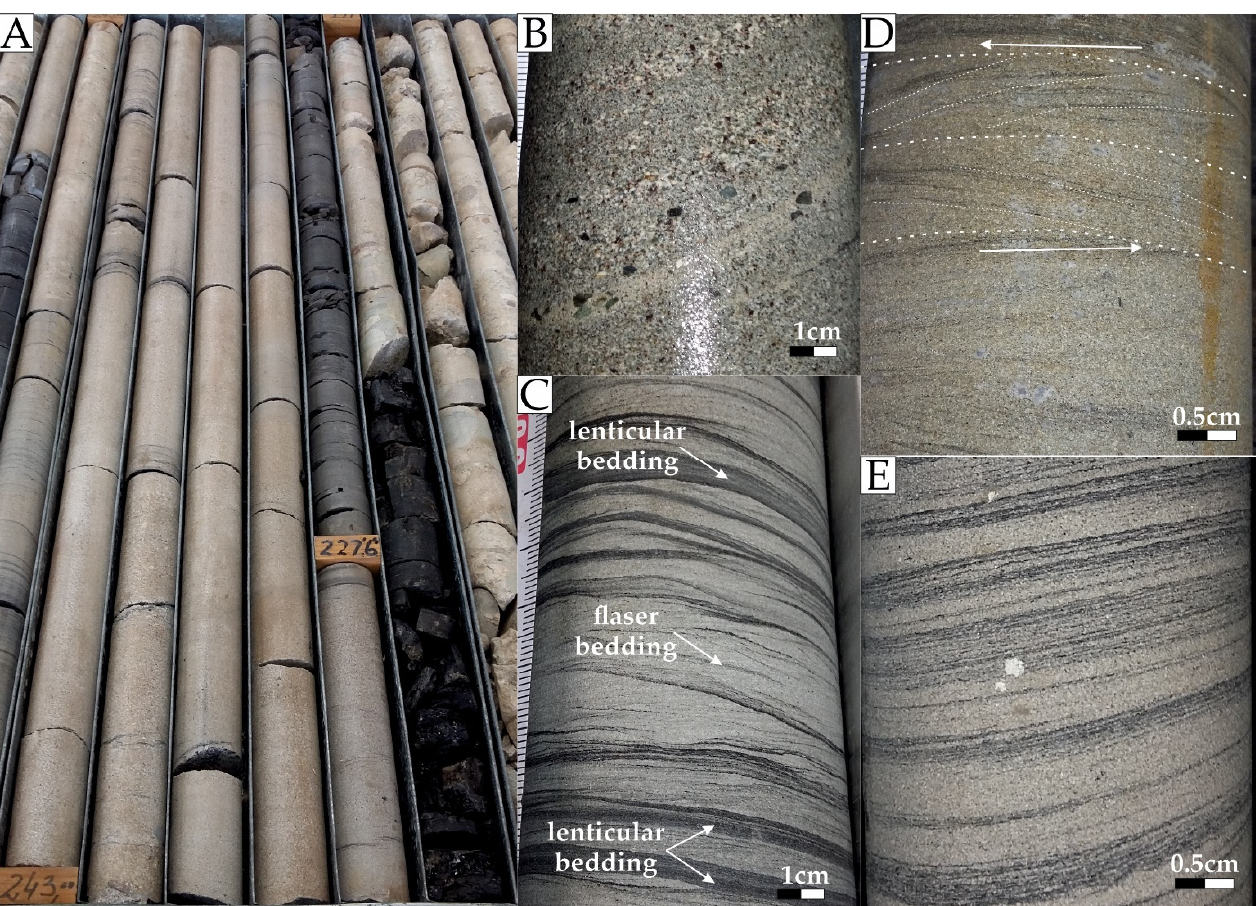
Figure 5. Core photographs illustrating sedimentological characteristics of the FA3 (lower delta-plain channels). ( A ) Structureless sandstone of FA3 that evolves into muddy deposits (FA4) and coal (FA5). The overlying conglomeratic facies correspond to upper delta-plain deposits. ( B ) Planar cross-bedded sandstone. ( C ) Heterolithic bedding with repetitions of flaser, wavy and lenticular bedding. ( D ) Bi-polar cross-bedded sandstone that suggests flow reversal during deposition. ( E ) Mud drapes with systematic variation in thickness representing deposition during neap and spring periods.